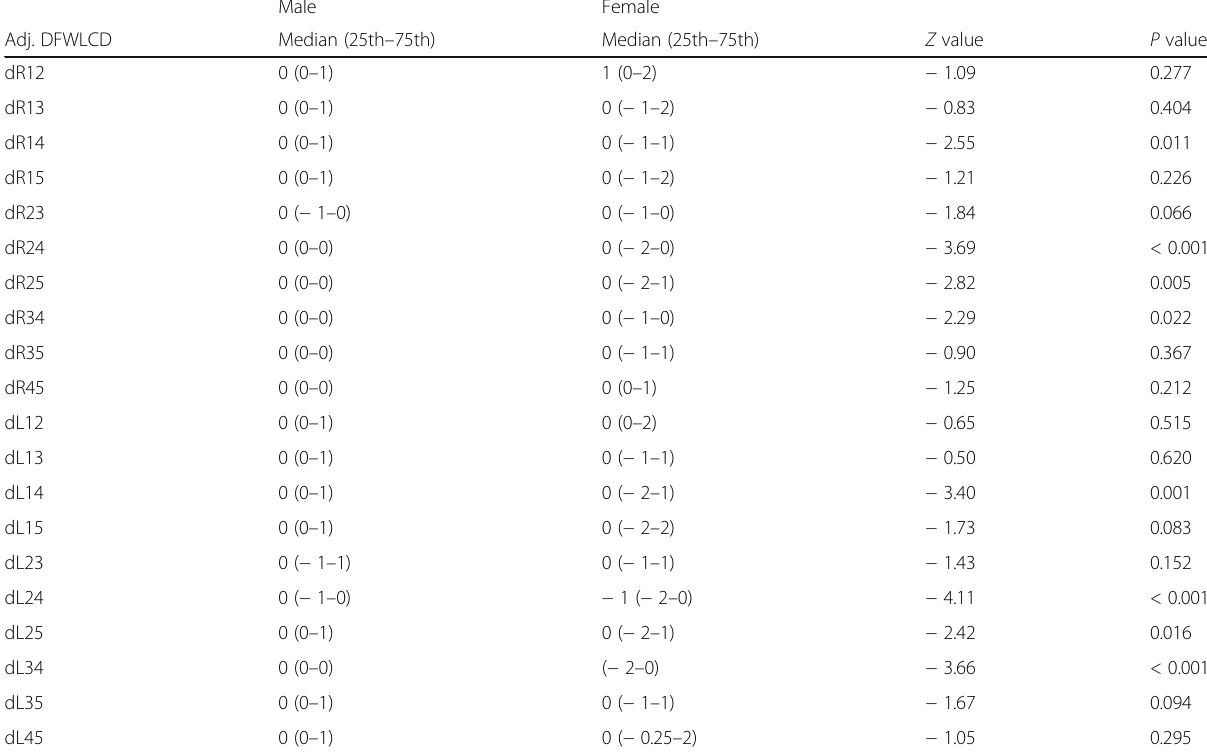
Table 3 Sexual dimorphism in FWLC adjacent digit asymmetry of the right and left digits Male Female Adj.